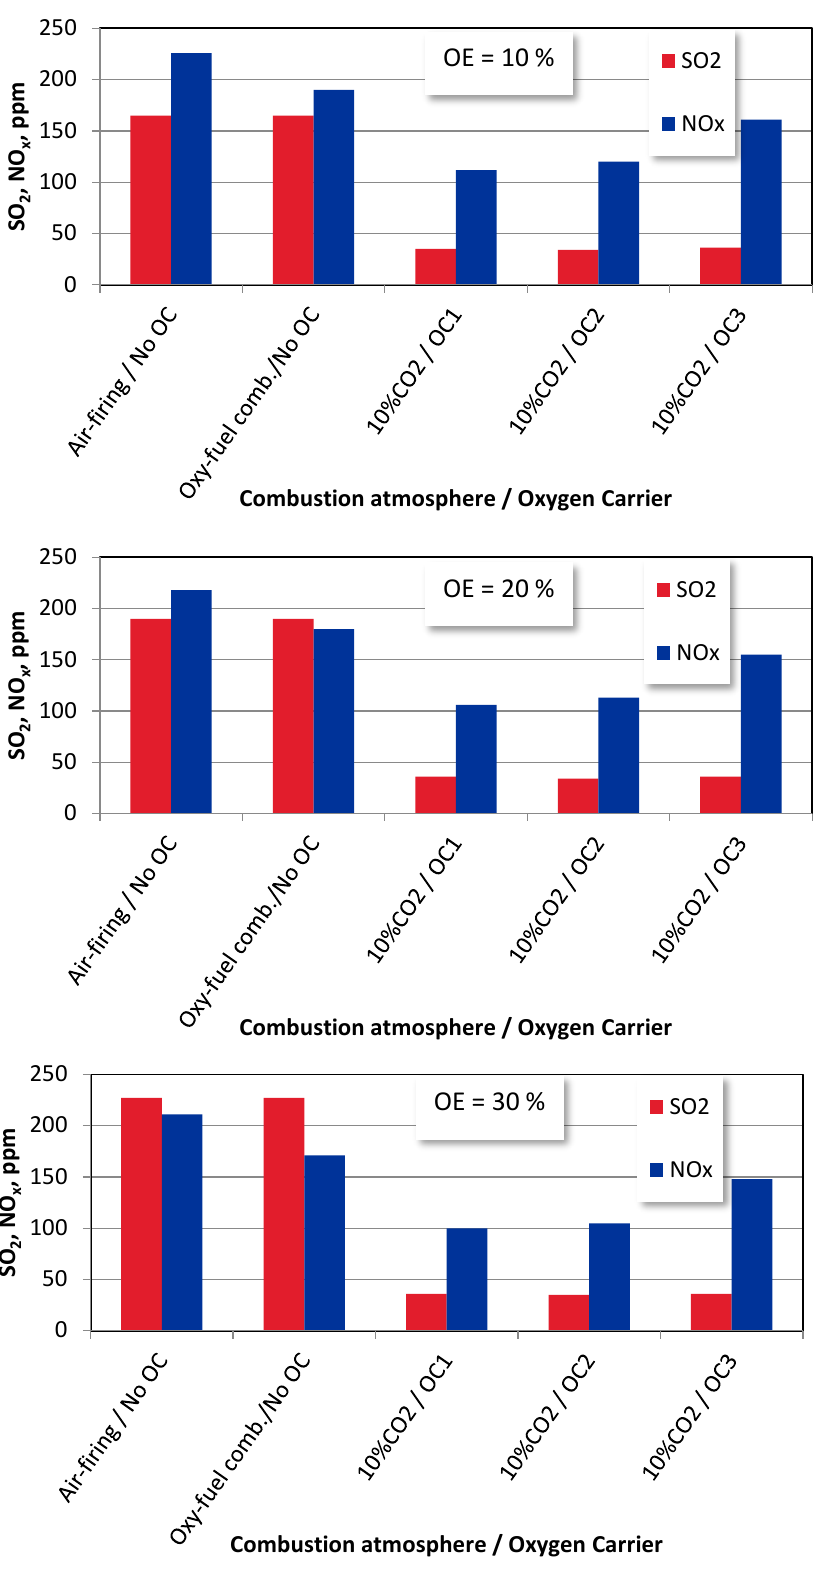
Figure 8. The effect of oxygen excess on SO 2 and NO x emissions from bituminous coal combustion under different combustion modes (T = 1100 K).